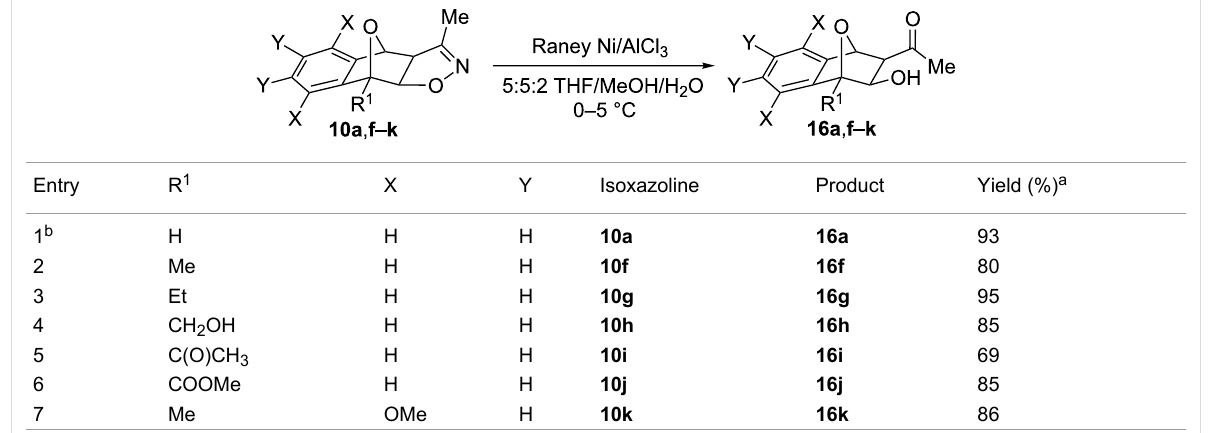
Table 3: Effects of bridgehead substitution on Raney Ni/AlCl 3 mediated cleavage of 7-oxabenzonorbornadiene-fused 3-methyl-2-isoxazolines.